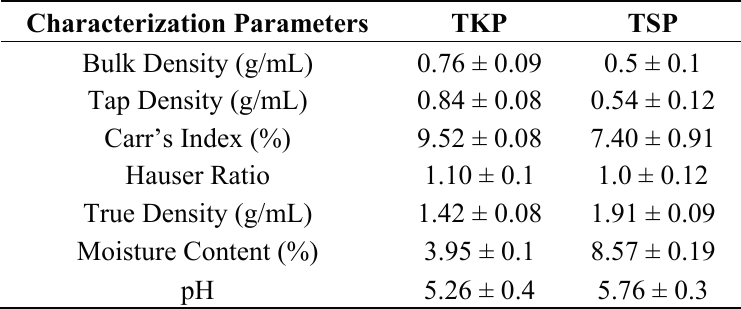
Table 1. Physico-chemical characters of TKP and TSP ( n =